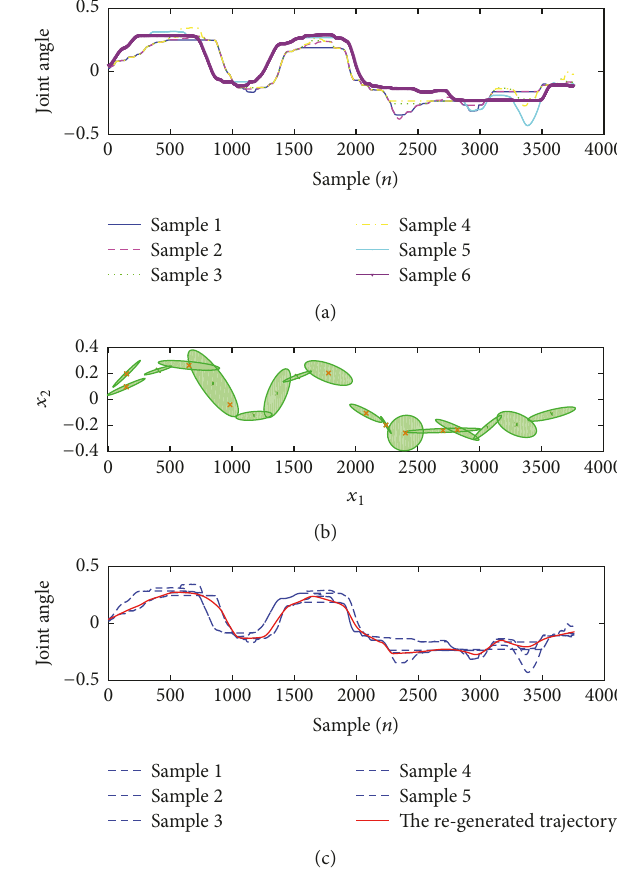
Figure 8: The learning process of the W-GMMs. (a) Training data samples in the joint space 𝑆0 . (b) Gaussian mixture components formed by the training data. (c) Regenerated (learned) trajectory from the